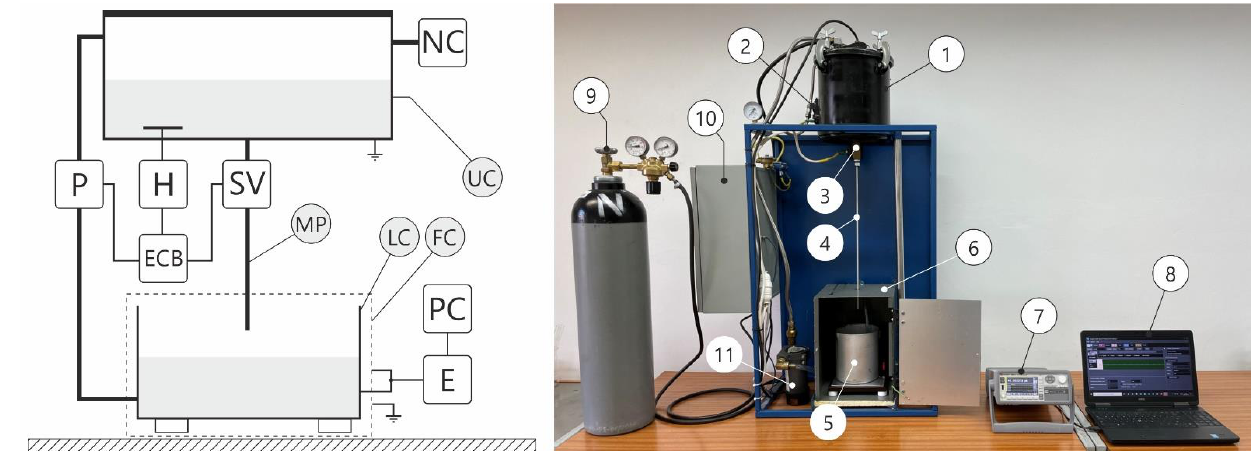
Figure 1. Flow system for testing of streaming electrification of insulating liquids: 1, upper container (UC); 2, heater (H); 3, solenoid valve (SV); 4, measuring pipe (MP); 5, lower container (LC); 6, Faraday cage (FC); 7, Keysight B2981A electrometer (E); 8, portable computer (PC); 9, nitrogen cylinder (NC); 10, electric control box (ECB); and 11, pump (P).